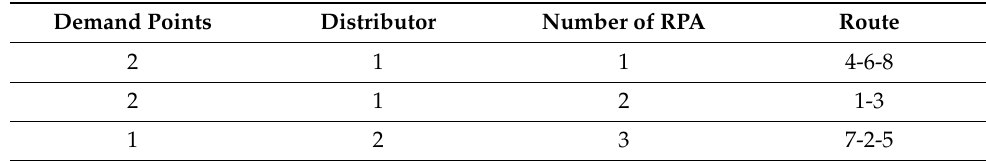
Figure 4. Problem solving by GAMS. Table 2. Solution of example.